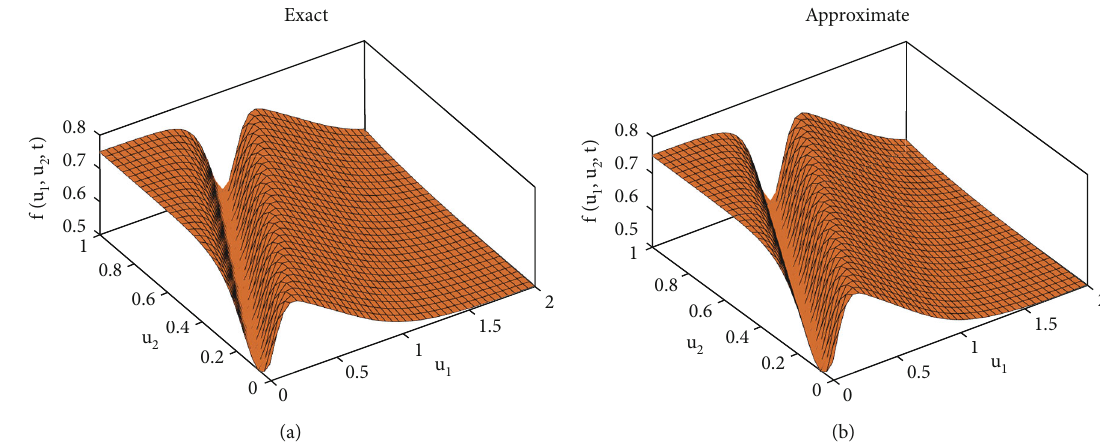
Figure 1: 3D view of the exact and approximate solution via JTDM of Example 16 for f ð u